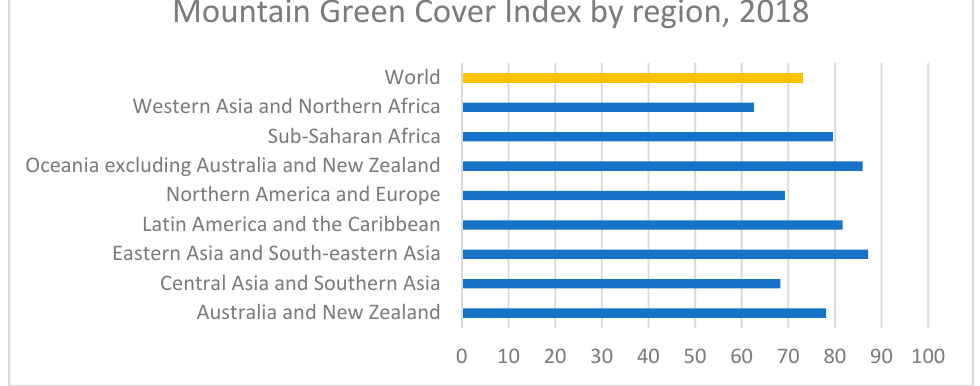
mountain cover between 69% and 68%.